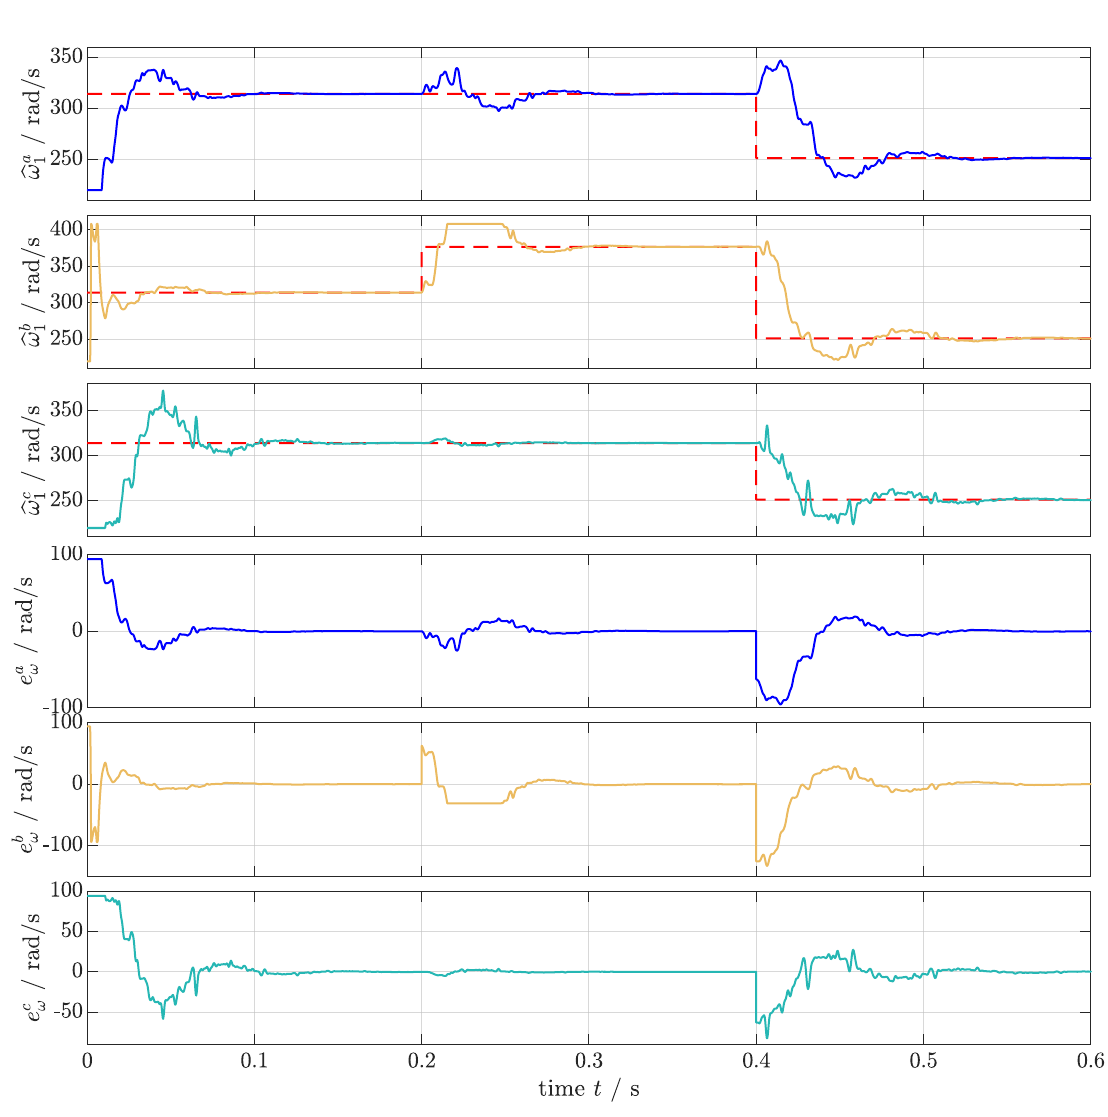
Figure 10. Simulation results for Scenario (S4): Fundamental angular frequency ω a its estimates (cid:98) ω a 1 , (cid:98) ω b 1 & (cid:98) ω c 1 , and errors e a ω , e b ω & e c ω (phase a : ; phase b : ; phase c : ). abc abc are shown from top to bottom, respectively (phase a : ; phase b : ; (cid:98) y − ,2 , and zero-sequence (cid:98) y 0,2 phase c : ). Since the second harmonic component is balanced for all time steps, the negative